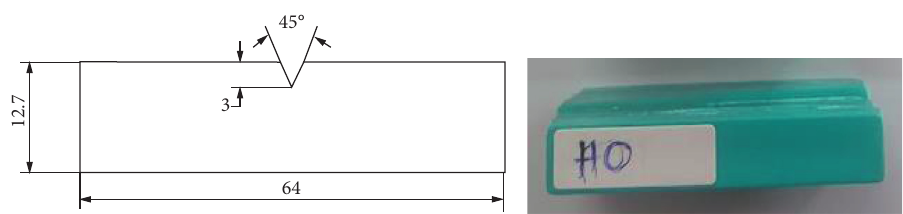
Figure 5: Sample size for Izod impact strength.